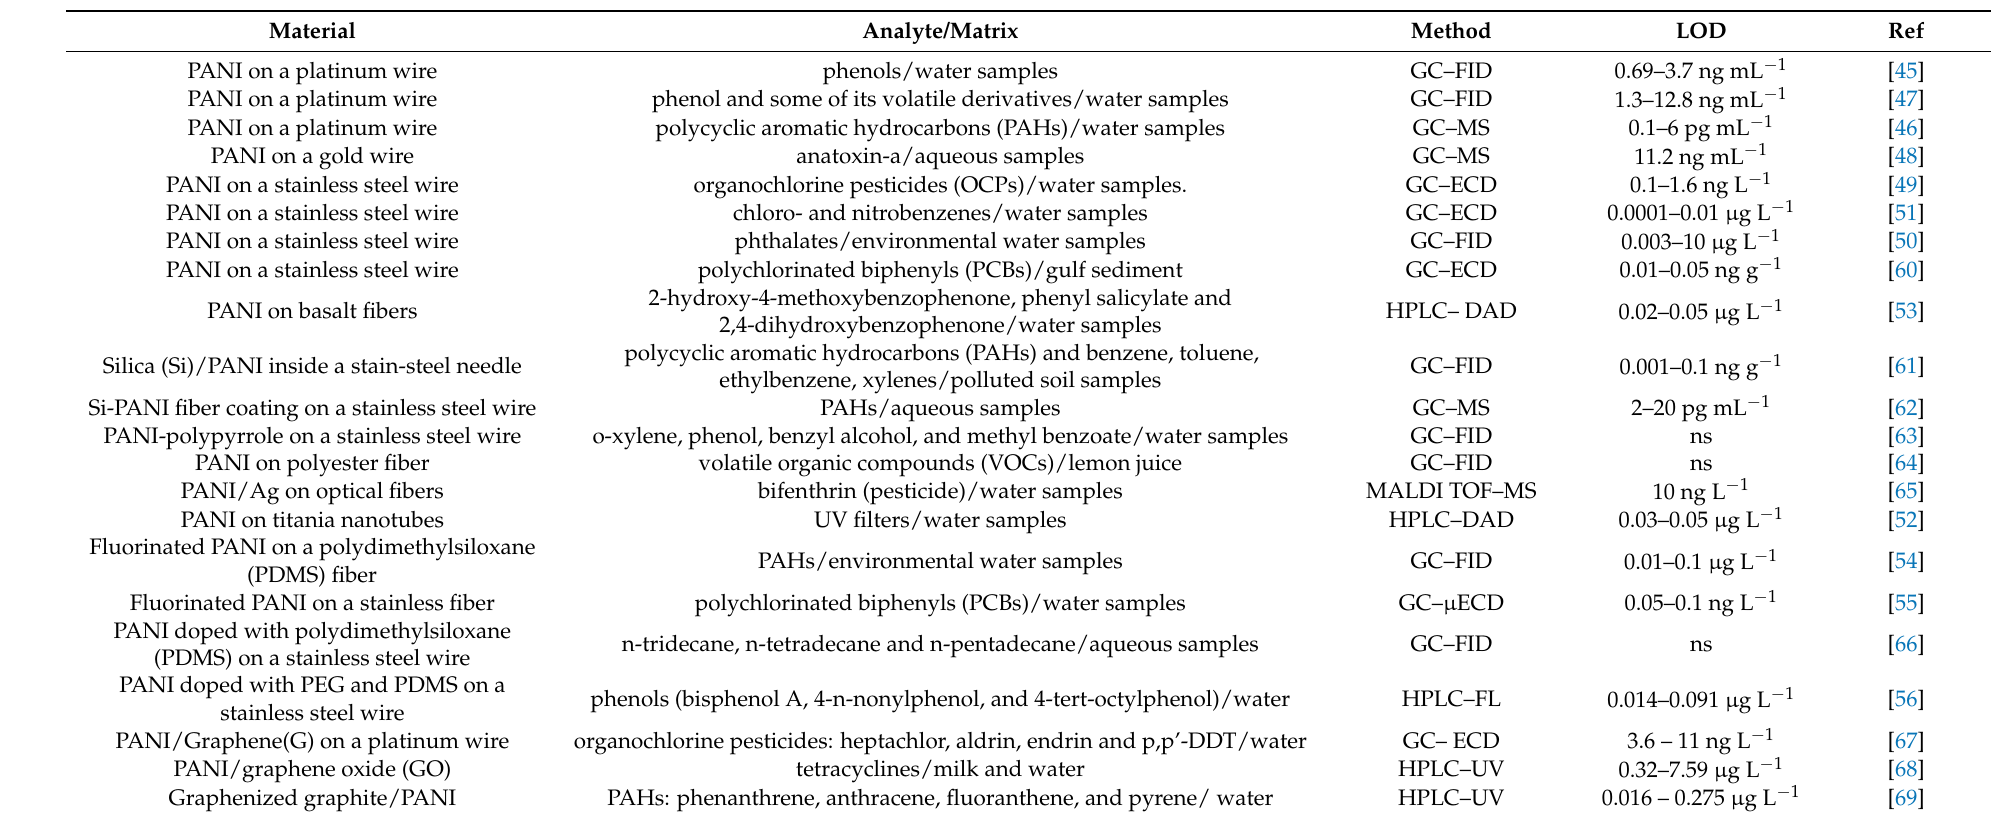
Table 2. Application of polyaniline and polyaniline composites in